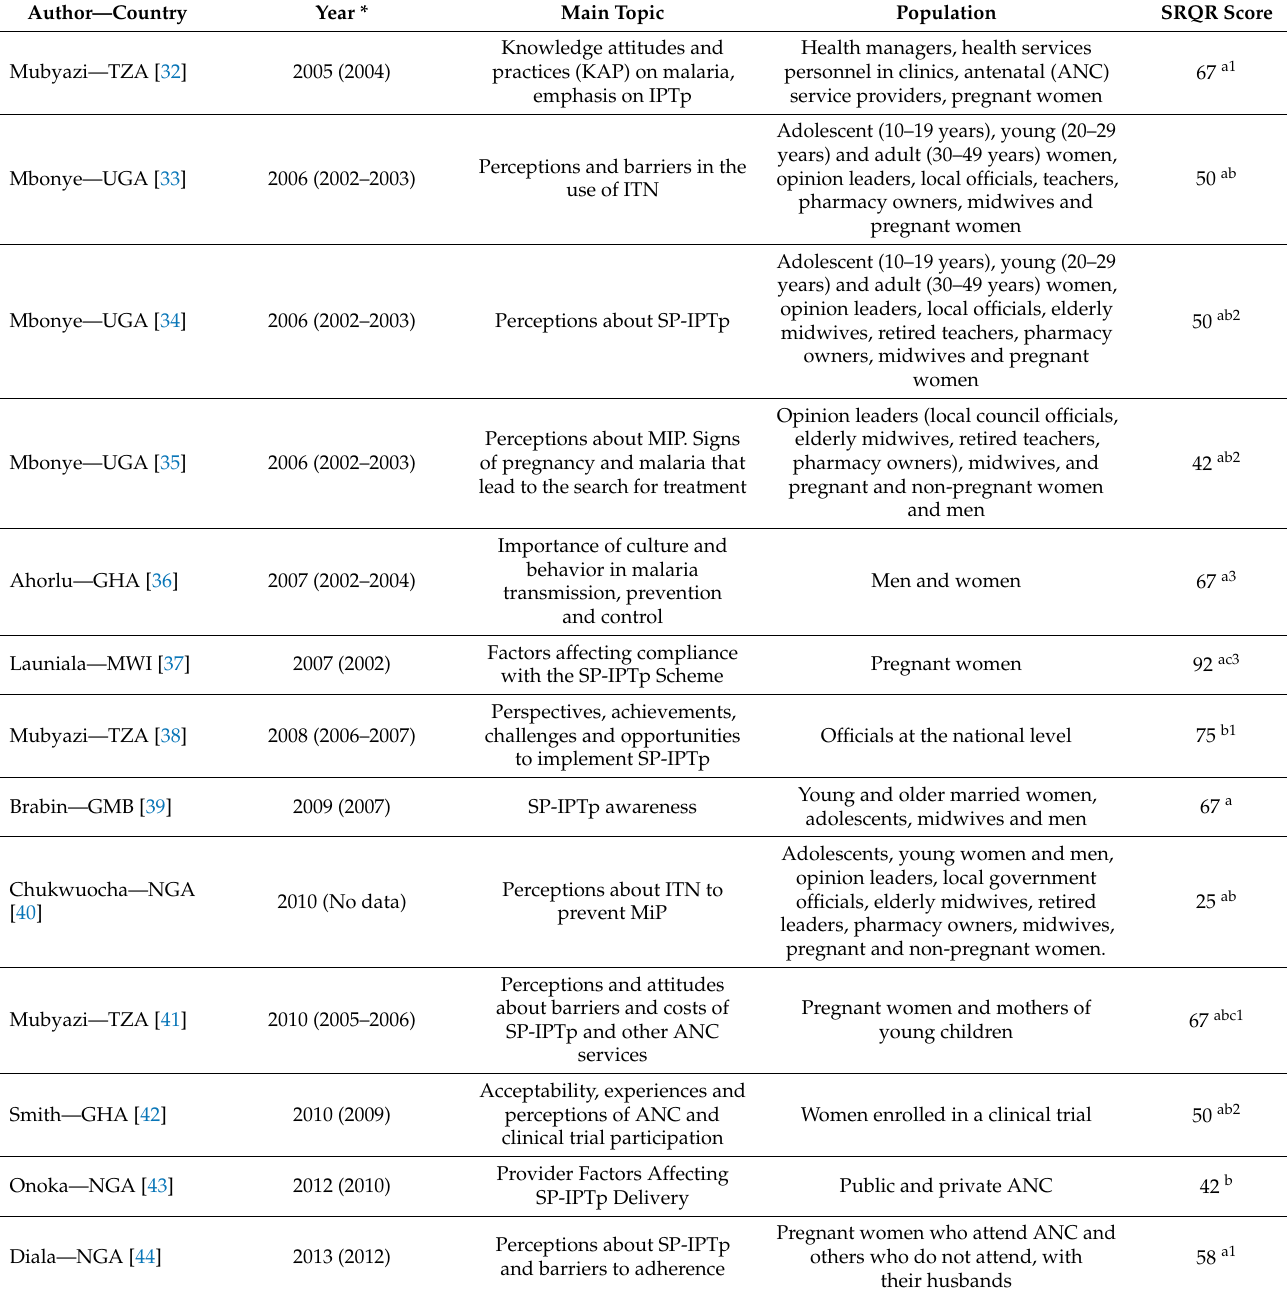
Table 1. Description of included studies by year, main topic, population, and methodological quality